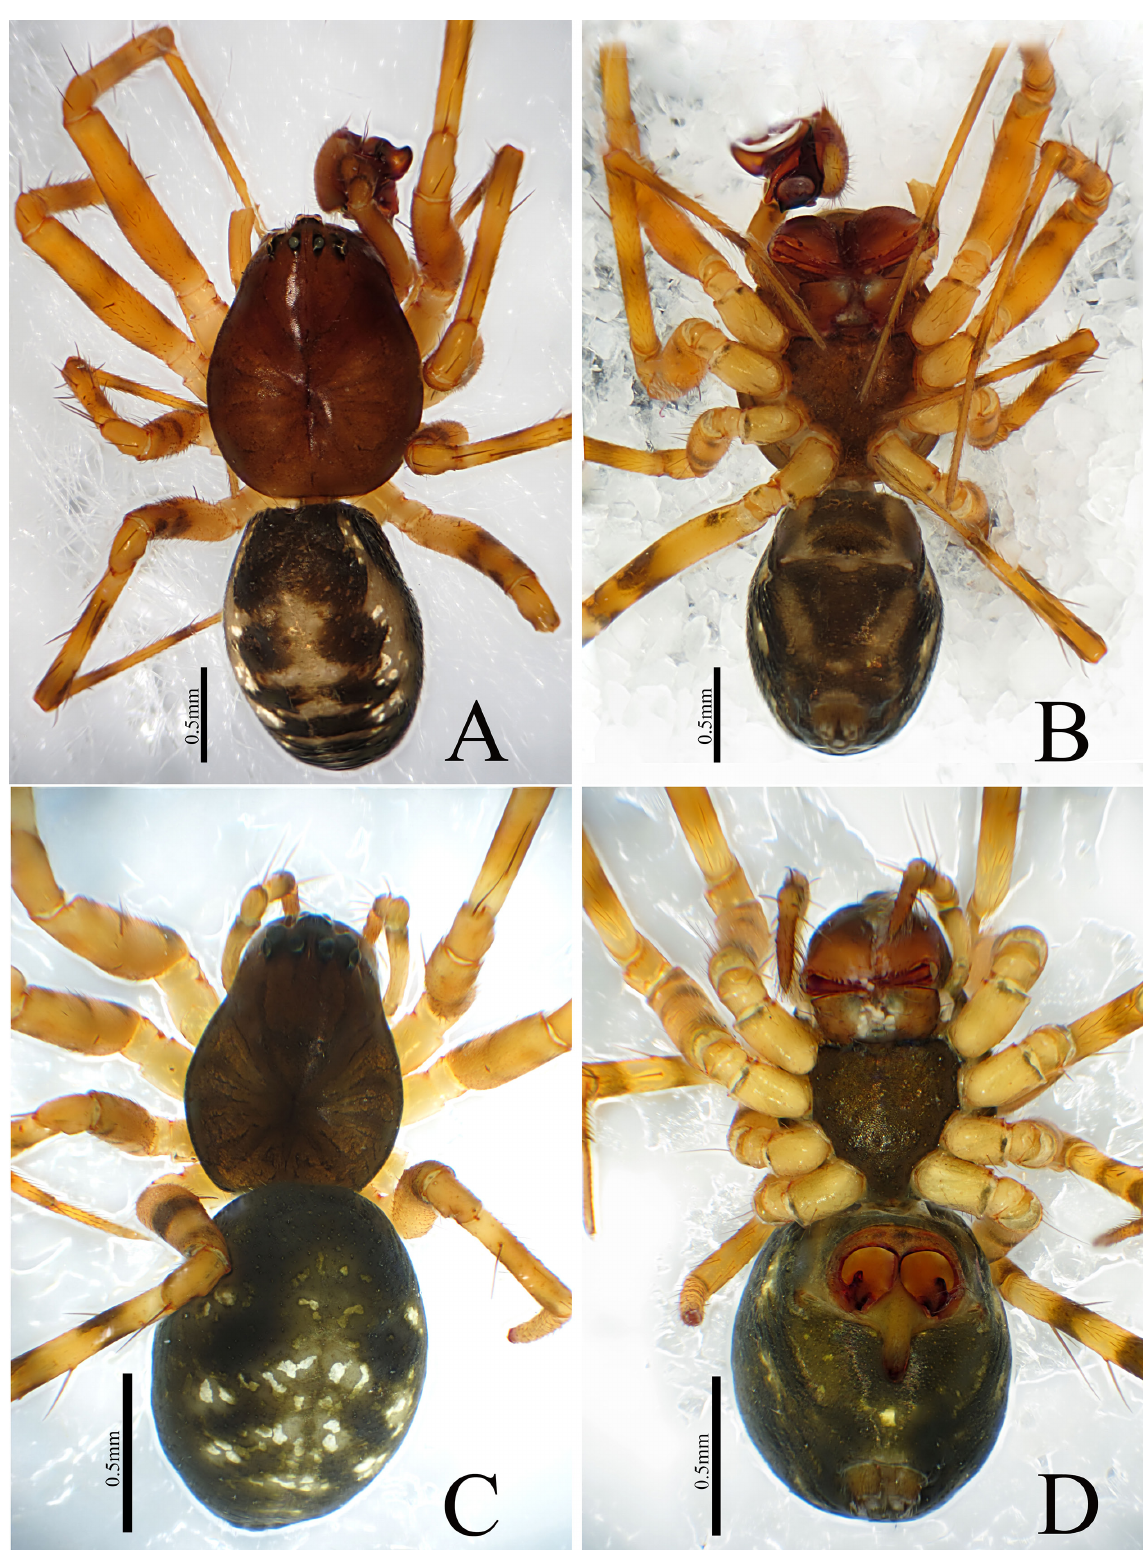
Fig. 9. Acroterius brevis gen. et sp. nov. A–B . ♂, holotype (HNU-20040501–1). C–D . ♀, paratype (HNU-20040501–2). A , C . Habitus, dorsal view. B , D . Habitus,